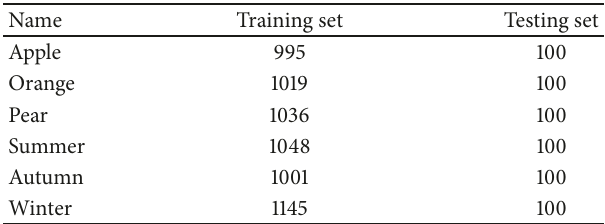
Table 1: Training and testing sets. We list the number of image in different data